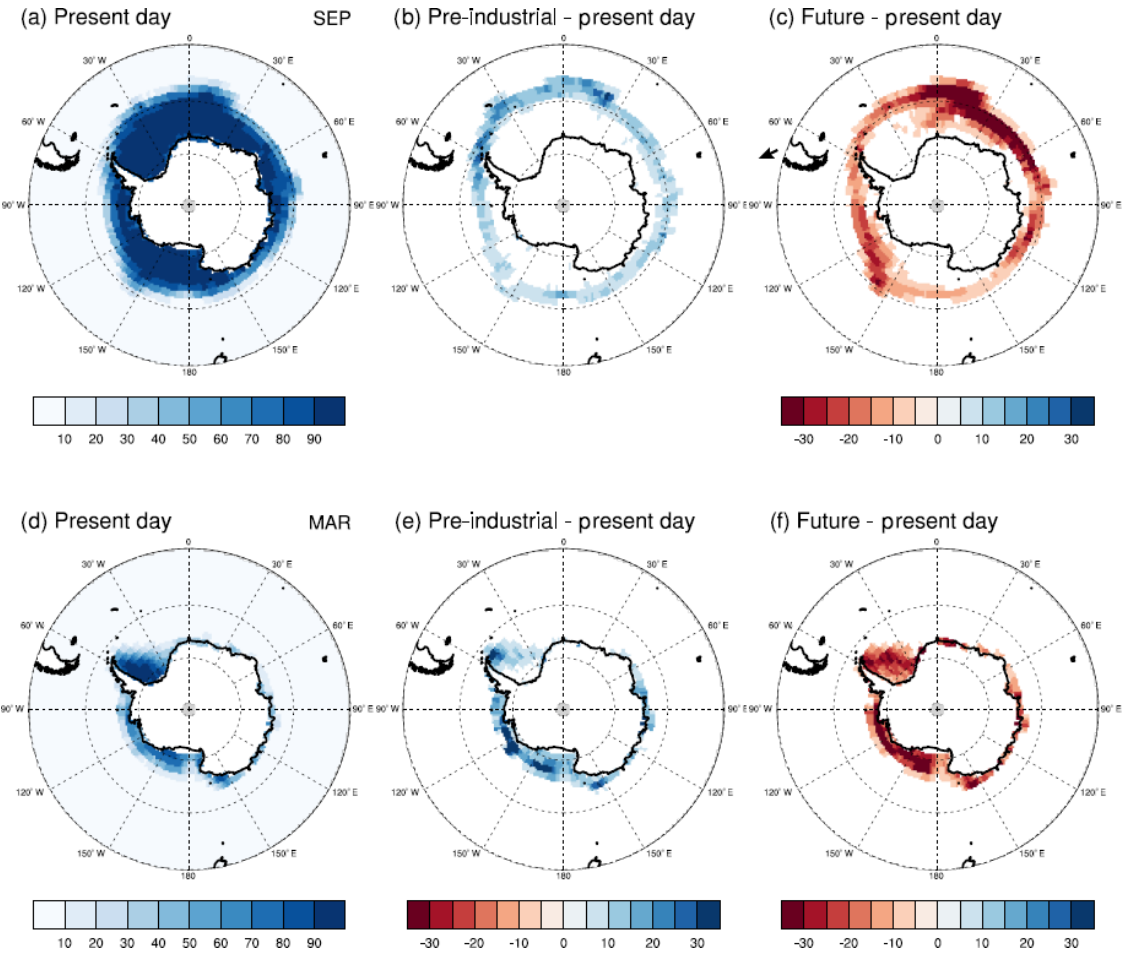
Figure 7. Antarctic sea ice forcing fields. Present-day Antarctic sea ice concentration for (a) September and (d) March. Differences from present-day fields are shown for (b, e) pre-industrial and (c, f) future